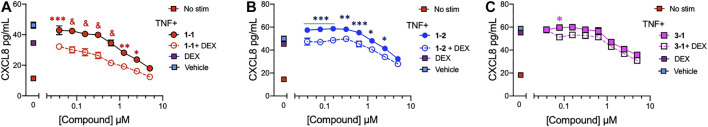
Potency of lead compounds combined with DEX in inhibiting CXCL8 production. Compounds 1–1; (A), 1–2; (B) and 3–1; (C) were added at the indicated concentrations and DEX was added at 100 nM with 0.04% final concentration of DMSO as vehicle to TNF 2 ng/ml stimulated THP-1 cells overnight. CXCL8 was measured in the supernatant. Data are represented as mean ± SEM and indicates p < 0.05, **p < 0.01, ***p < 0.001, & p < 0.0001 by two way ANOVA with Bonferroni post hoc test comparing compound vs. compound + DEX. Data are representative of two independent experiments showing similar results.